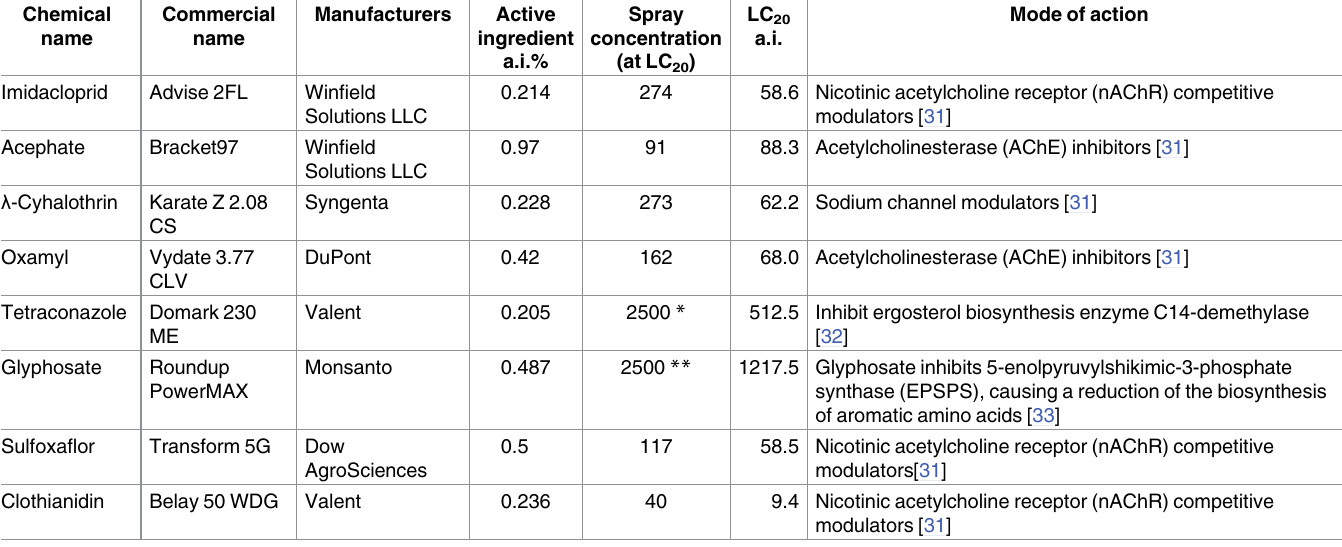
Table 1. Pesticide name, manufacturer, percentage of active ingredient, spray concentration of formulation, and mode of